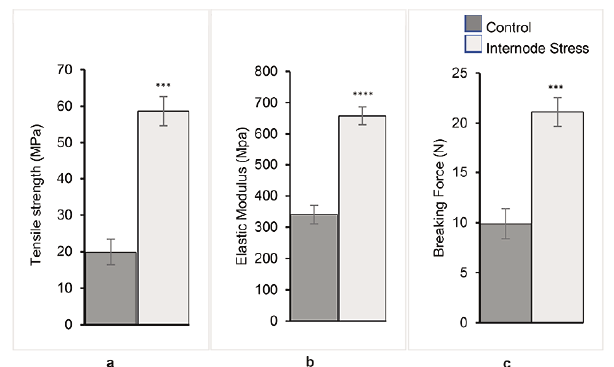
Fig. 5 ­ Biomechanical properties of the stem measured through tensile test: tensile strength (a), elastic modulus (b) and breaking force (c). Standard errors are indicated by verti­ cal bars. The values correspond to the Mean ± SE , where n=5. Asterisks indicate Mean values significantly differ at P<0.05 (*** indicate P=0.0007 and **** indicate